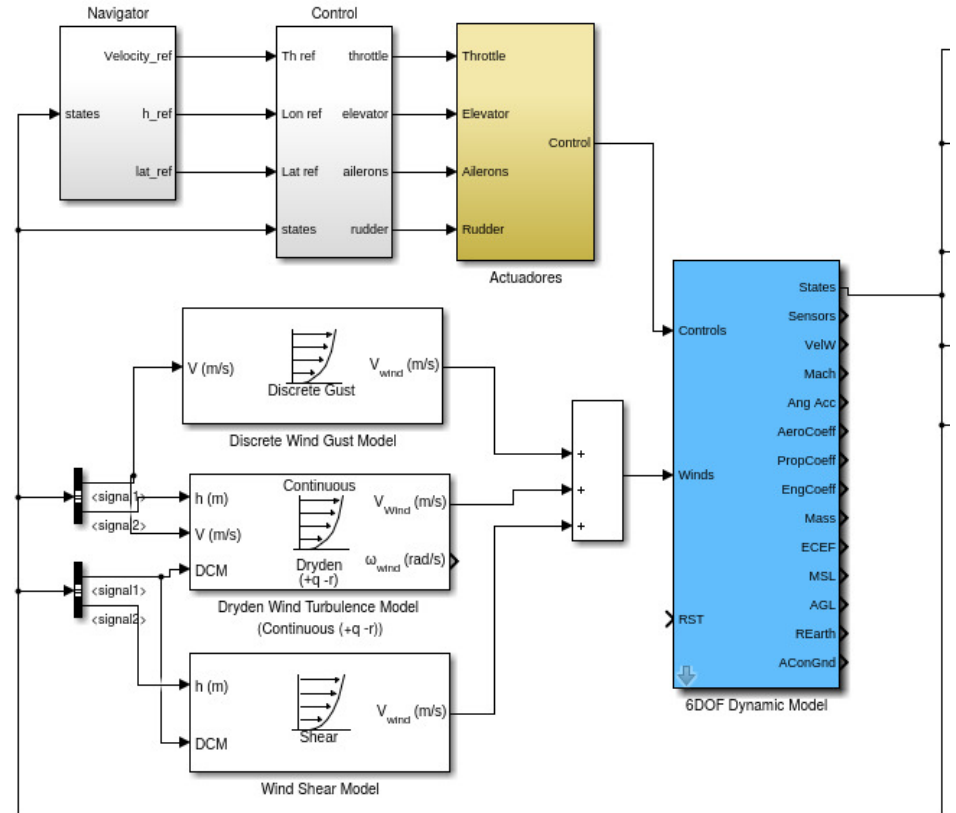
Figure 8. Simulink model of the simulation environment for the wind identification system.